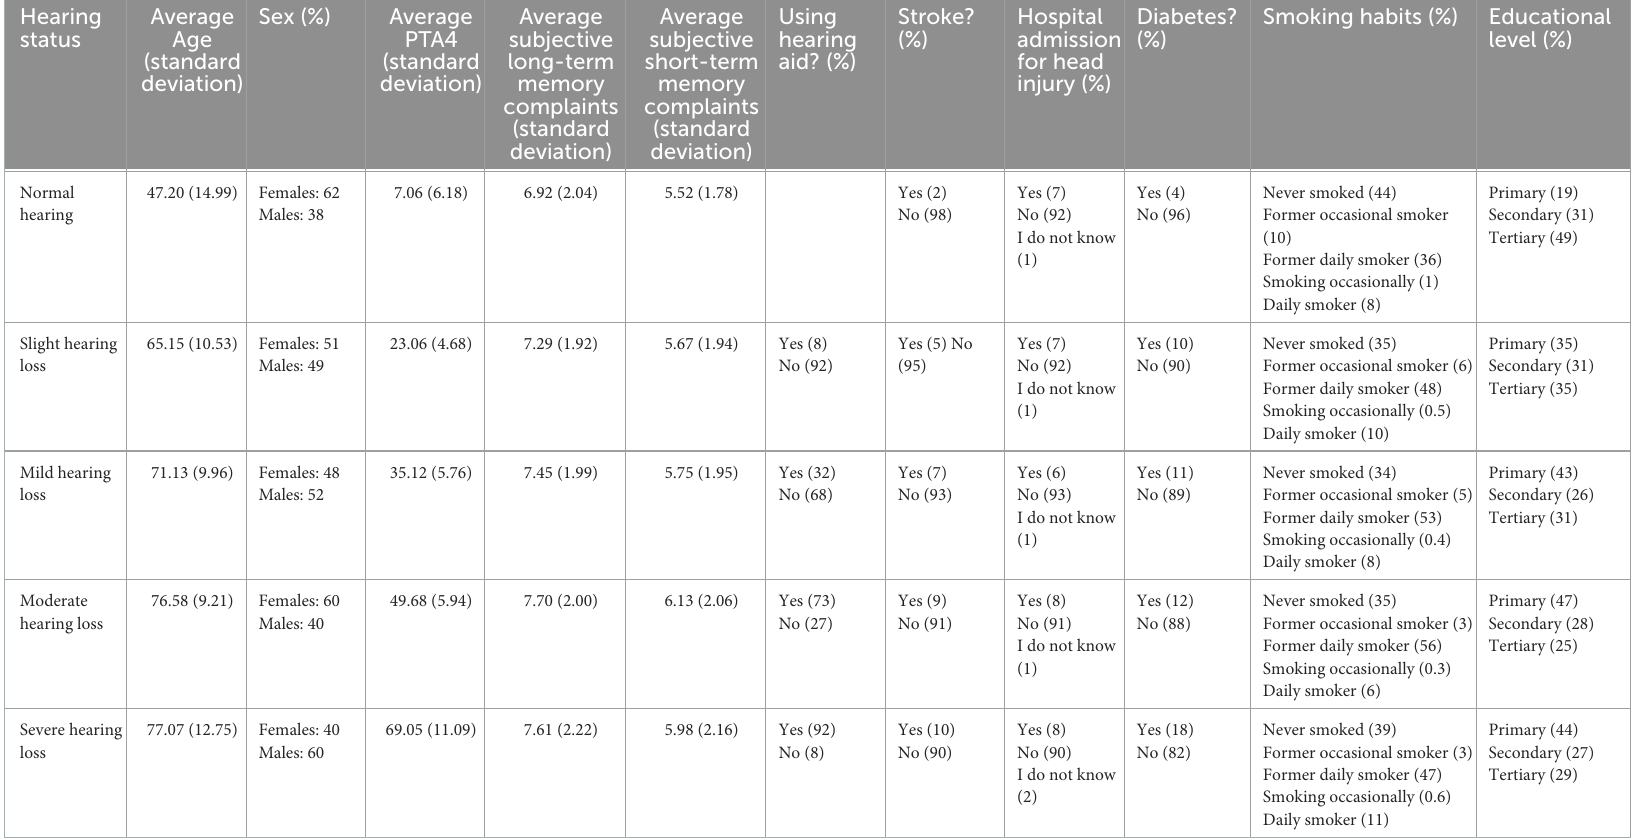
TABLE 1 Sample characteristics stratified by the hearing status of participants 463 ( n =